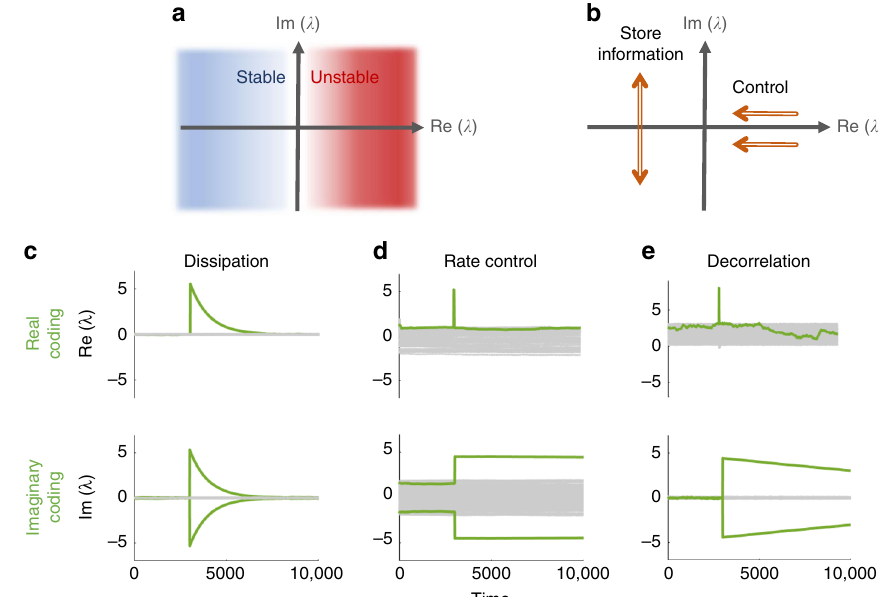
Fig. 2 Stability and memory-associated connectivity eigenvalues. a Eigenvalues of the Jacobian matrix occupy the complex plane. System stability about a set-point is ensured if all eigenvalues have negative real parts (i.e., reside in the blue half-plane). Eigenvalues with positive real parts (in the red half-plane) correspond to locally unstable directions. b Homeostatic control that prevents noise from accumulating and causing divergence, also affects stored memories represented by the eigenvalues. However, such mechanisms must only control their positive real parts, pushing them to be negative (arrows), while in the left half-plane large-amplitude imaginary eigenvalues can persist. c – e Real (top) and imaginary (bottom) parts of connectivity ( W ) eigenvalue spectra for systems evolving under the dynamics of Eqs. (1) and (2), with different homeostatic mechanisms in Δ F ( N = 128, see “ Methods ” for simulation details). For each case, a memory item was embedded in W at time t = 2500 (green trajectories), by inducing a real outlier eigenvalue (top panels, generated by the perturbation δ W = uu ⊤ ) or an imaginary pair (bottom panels, generated by δ W = uv ⊤ − vu ⊤ ). c Dissipation of synapses. Both real and imaginary memories decay with the same rate. d Homeostatic rate-control. e Decorrelation homeostasis. In the last two, real-coded memory (top) decays rapidly whereas imaginary-coded (bottom)